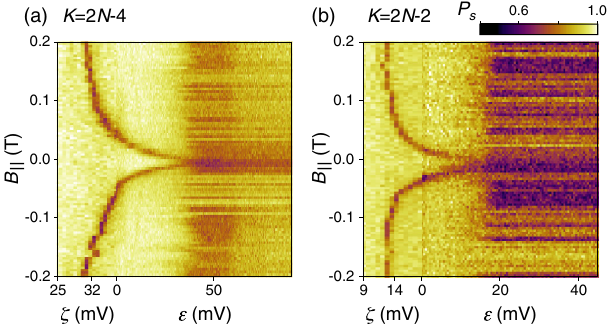
FIG. 4. Leakage spectroscopy of the double dot coupled to the multielectron dot at the transition between (a) ð 2 ; 0 ; 2 N − 2 Þ , ð 1 ; 1 ; 2 N − 2 Þ , and ð 1 ; 0 ; 2 N − 1 Þ and (b) ð 2 ; 0 ; 2 N − 4 Þ , ð 1 ; 1 ; 2 N − 4 Þ , and ð 1 ; 0 ; 2 N − 3 Þ